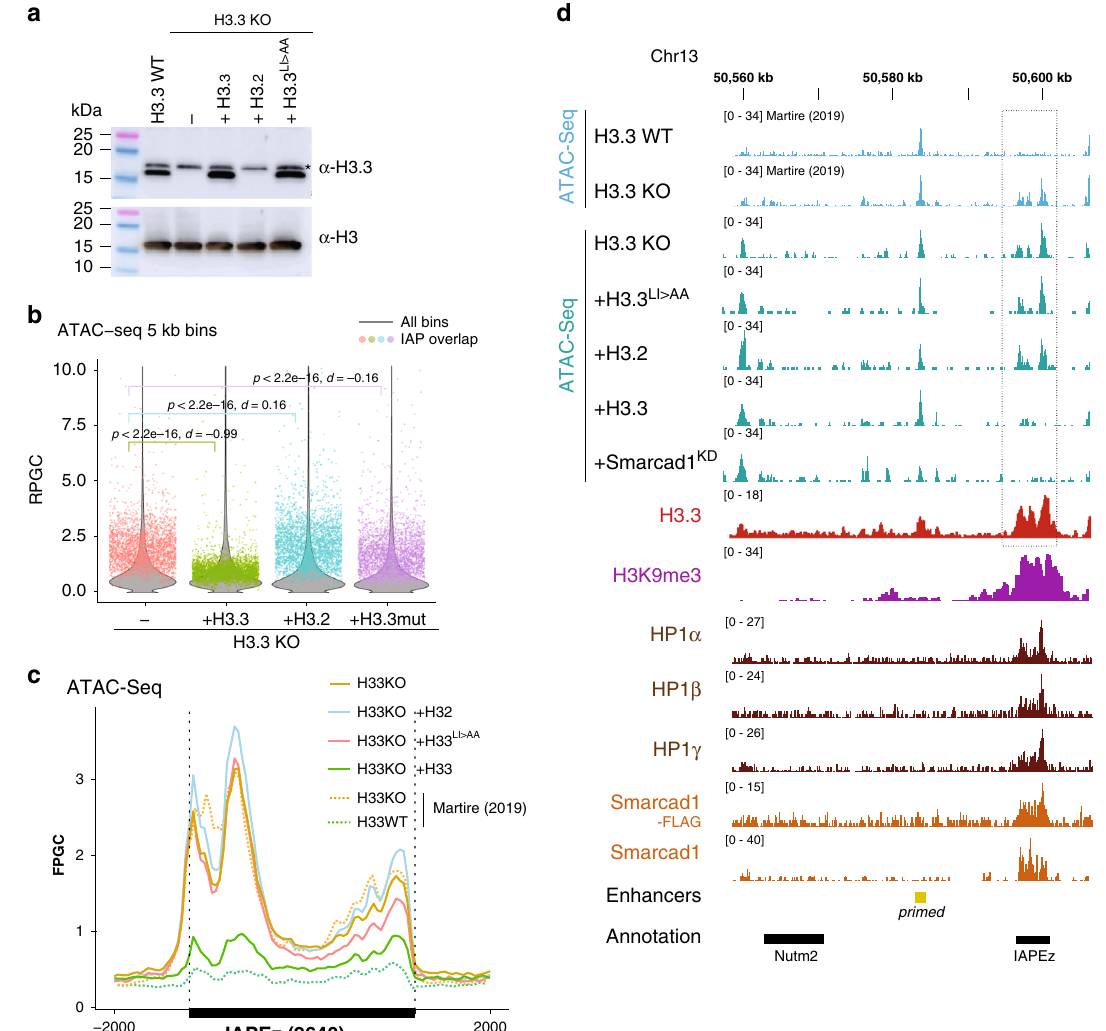
Fig. 4 Histone H3.3 nucleosome assembly is strictly required for maintaining inaccessible state. a Western blot showing complementation of H3.3 knockout (KO) cell line with transgenes stably expressing wildtype H3.3, H3.2 or a H3.3 L126A I130A (H3.3 LI>AA ) mutant incapable of forming nucleosomes. Representative image of n = 2 independent experiments. b Violin plots showing genome-wide distribution of ATAC-Seq signal in 5 kb bins, in H3.3 KO cell line, or H3.3 KO cell lines complemented with wildtype H3.3, H3.2 or a H3.3 LI>AA . Overlayed in color are 2797 individual bins overlapping